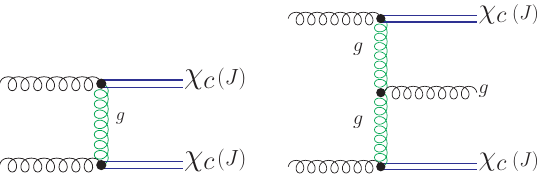
Figure 1. Diagrams for production χ c pairs. In the left panel there is a leading order process and in the right panel there is pair production associated with extra gluon